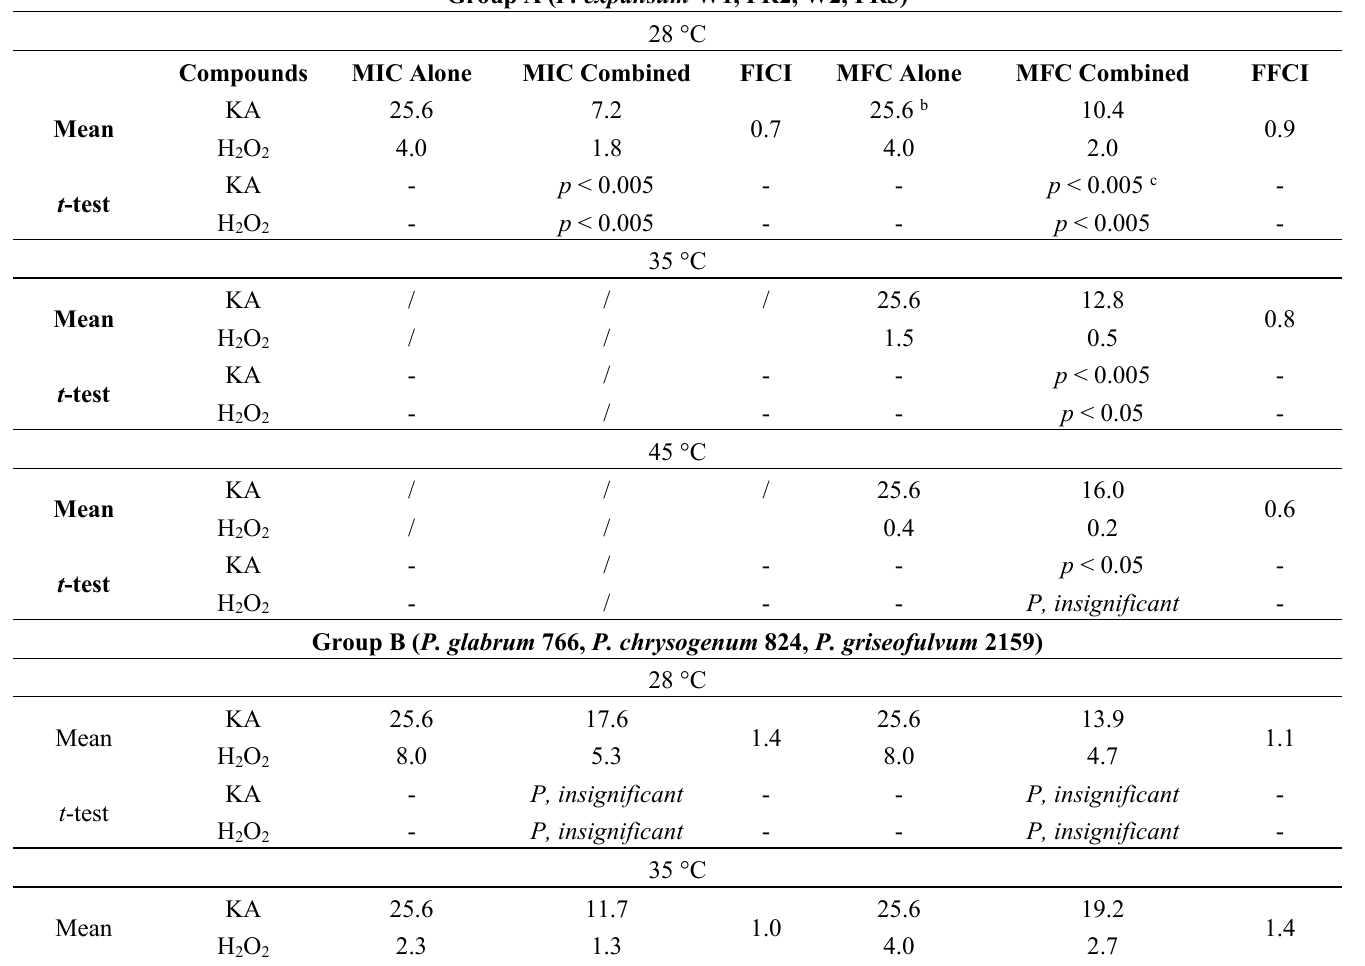
Table 2. Antifungal chemosensitization of kojic acid (KA; mM) to hydrogen peroxide (H 2 O 2 ; mM) at different temperatures tested against Penicillium strains. Summary of CLSI-based microdilution bioassays (Average MIC/FICI and MFC/FFCI values of Group A, B, C strains at 48 h) a